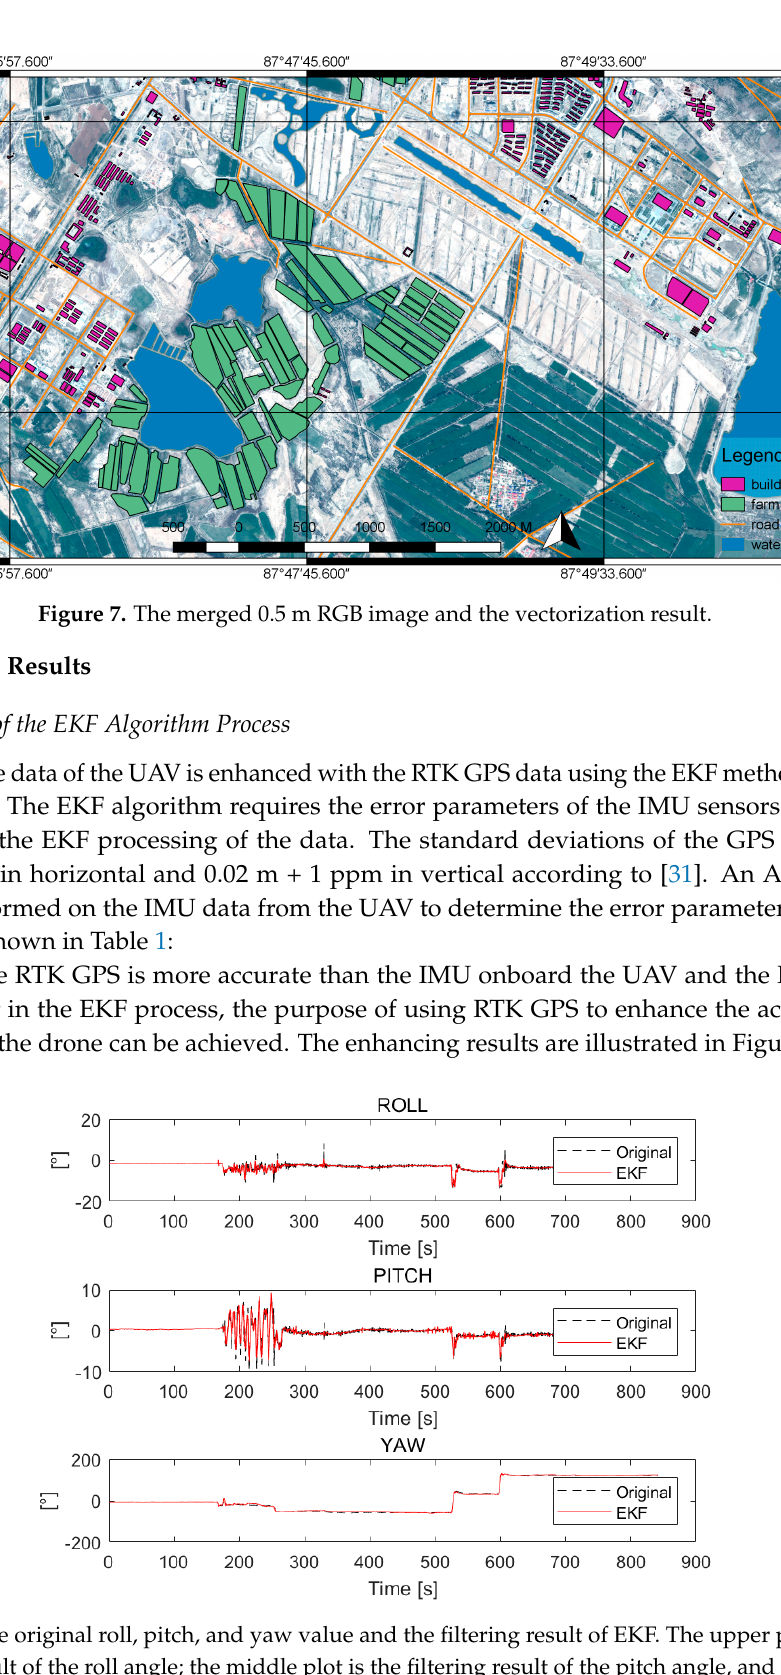
Figure 6. The satellite image of the test zone. ( a ) The full-color image that has 0.5 m ground resolution; ( b ) The color image that has 2 m ground resolution.